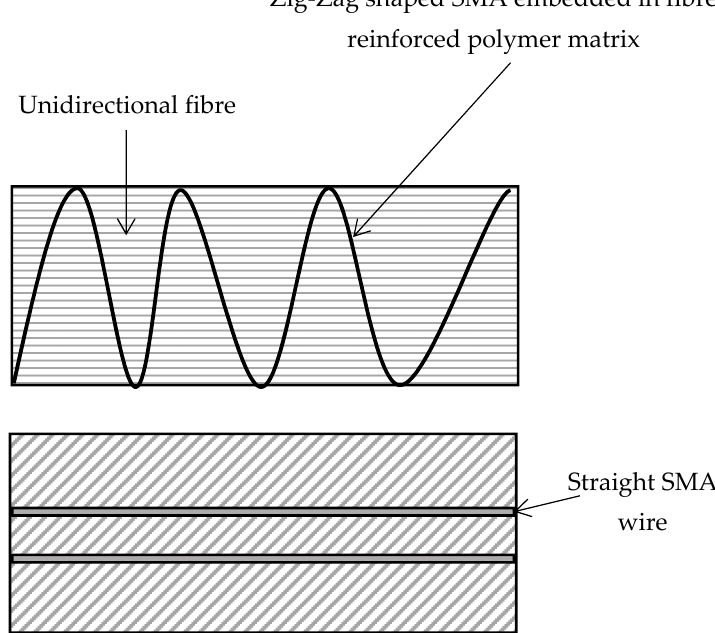
Figure 1. Integration of SMA into a Fibre-Reinforced Polymer Composite.